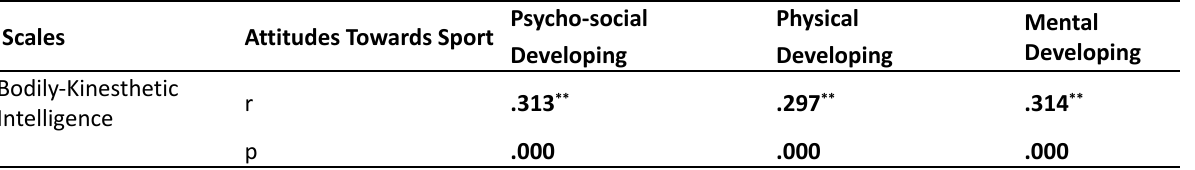
Table 8. Evaluation of the relationship between attitudes towards sport and bodily-kinesthetic intelligence.